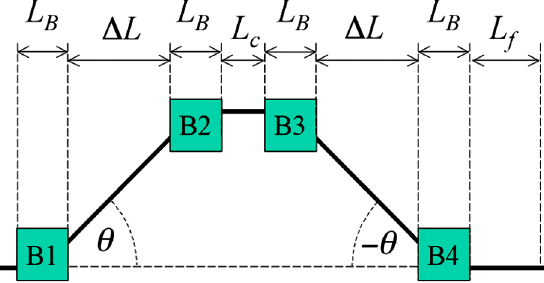
FIG. 6. Schematic of the Berlin-Zeuthen chicane lattice.